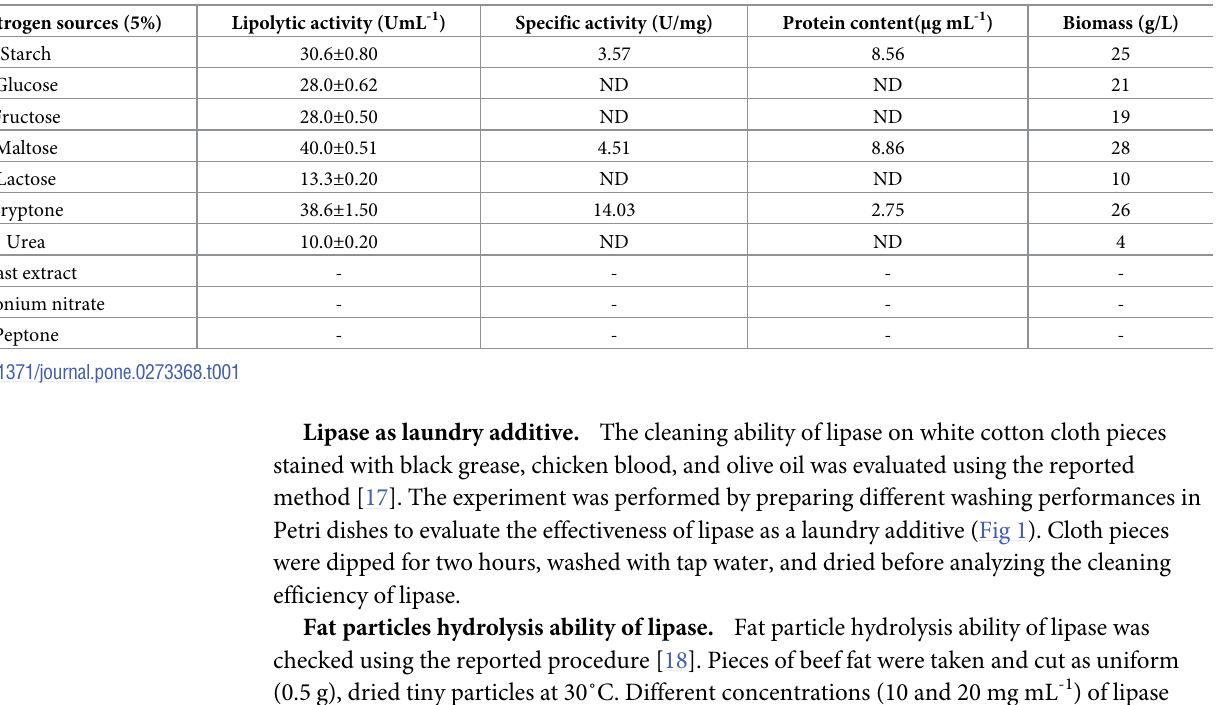
Table 1. Effect of carbon and nitrogen sources on lipase production by B . cereus NC7401.